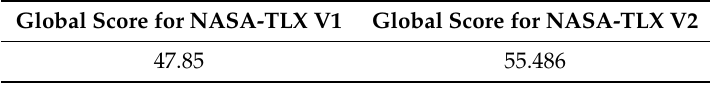
Table 6. Global score results of the NASA-TLX